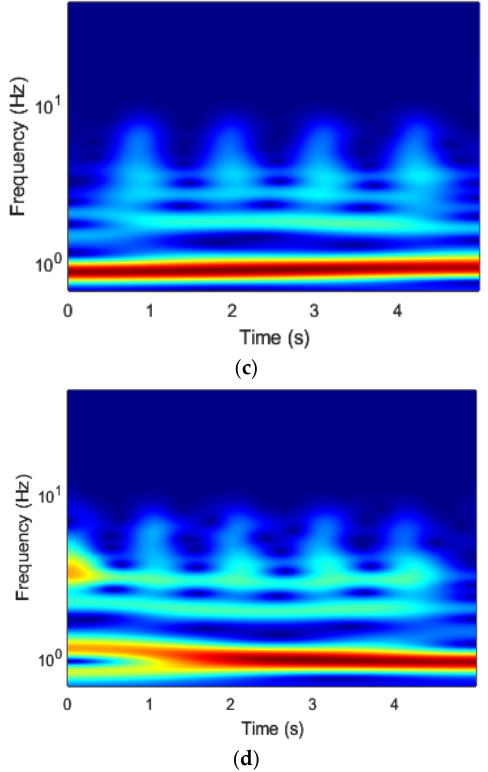
Figure 9. Examples of signals that have been transformed using the generalized Morse wavelet, in both ( a , b ) stressed and ( c , d ) non-stressed conditions, from various